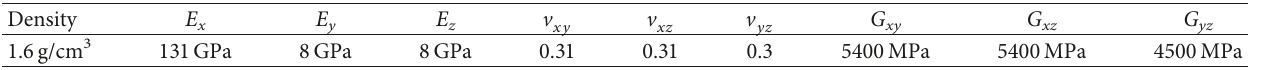
Figure 18: Deformations of sample 8 after impact in (a) experiment and (b) simulation. Table 9: Basic properties of carbon/epoxy